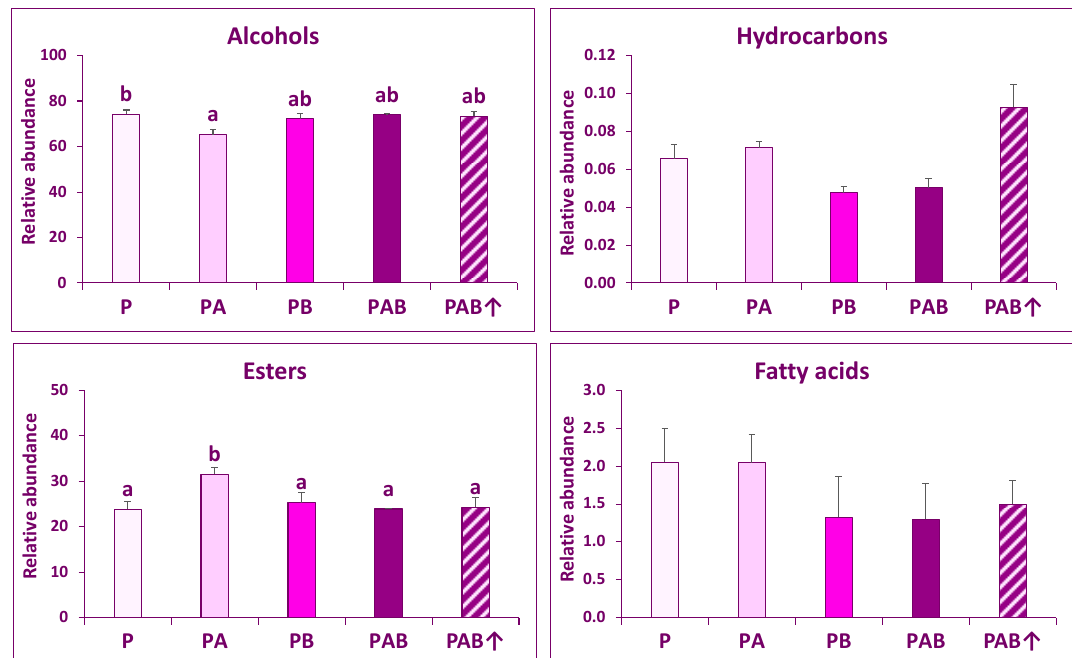
Figure 2. Relative abundance (percentages) of families of volatile organic compounds (VOCs) in wines made from grapes exposed to five different radiation regimes: P (only PAR), PA (PAR + UV-A), PB (PAR + UV-B), PAB (PAR + UV-A + UV-B), and PAB ↑ (PAR + UV-A + enhanced UV-B). For each variable, different letters indicate significant differences between radiation regimes (post hoc Tukey test after a one-way ANOVA test using radiation regime as main factor). Means ± SE are shown.